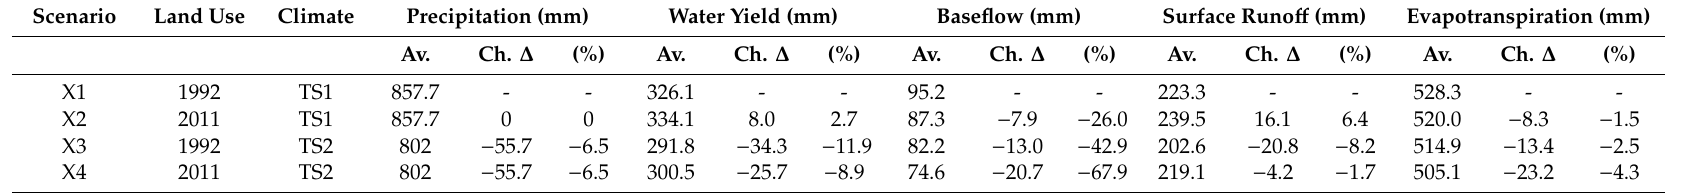
Table 10. Average annual change in water balance components in Walzem Creek